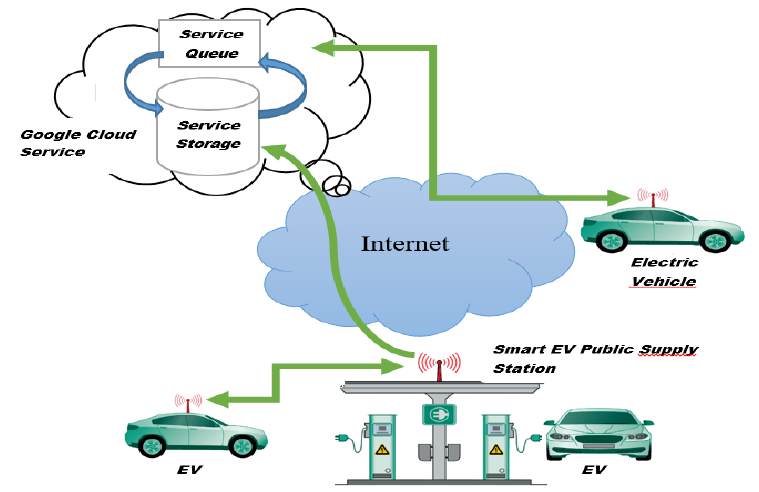
Figure 1. General architecture of smart grid. Reproduced with permission from [12].